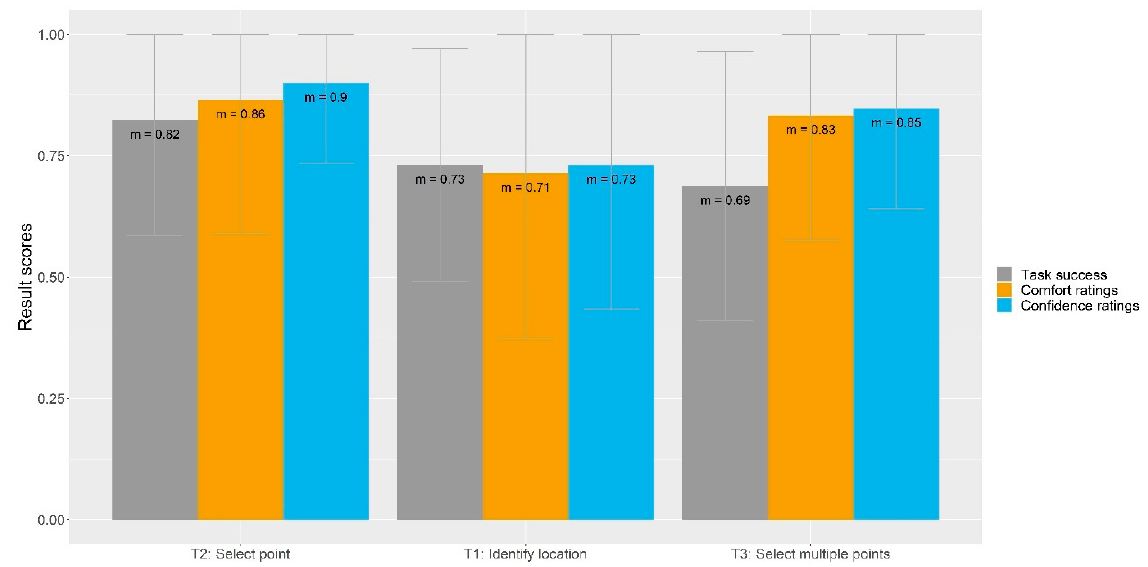
Figure 8. Task success, comfort, and confidence ratings by task.